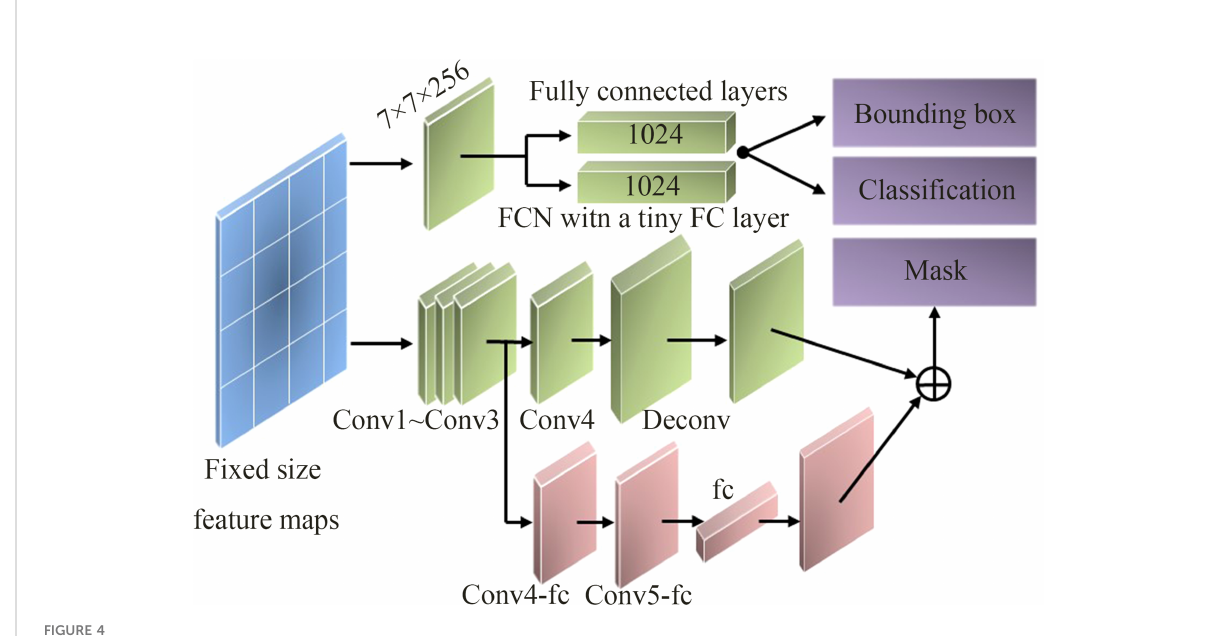
FIGURE 4 Improved three-branch